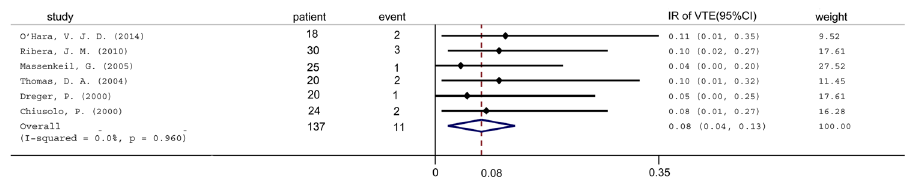
Figure 6. Pooled incidence of venous thromboembolism in transplant recipients. IR = incidence rate. VTE = venous